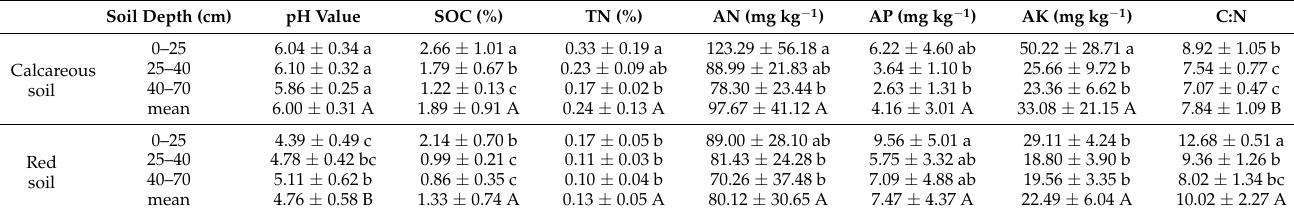
Data are means ± SD; identical lowercase letters indicate no significant differences among all soil layers in calcareous and red soils at p = 0.05, N = 12; identical uppercase letters indicate no significant differences in average values between calcareous and red soils at p = 0.05, N = 36, the same as below.